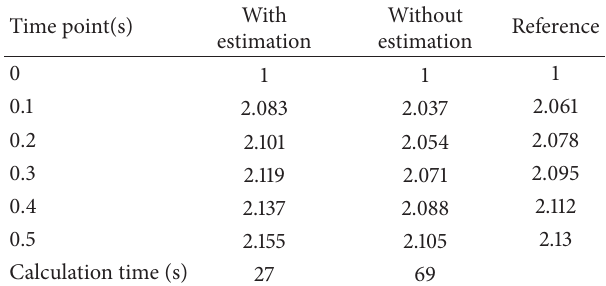
Table 9: Normalized power versus time with and without flux estimation in TWIGL problem during step perturbation.